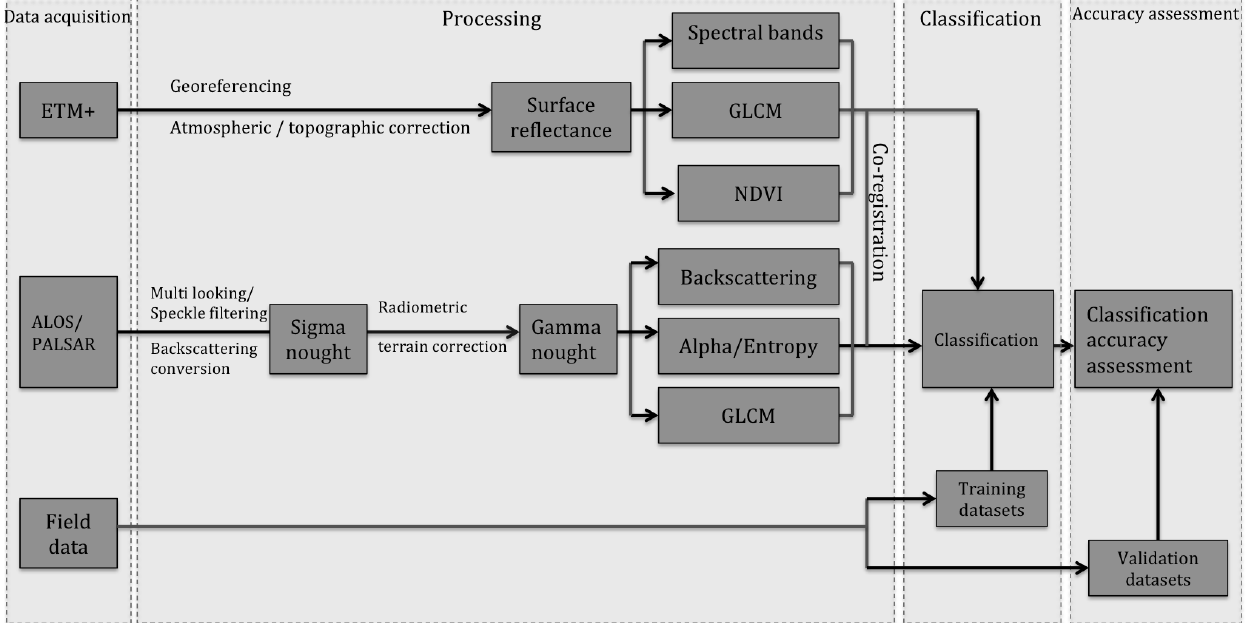
Figure 2. Flowchart of the proposed classification